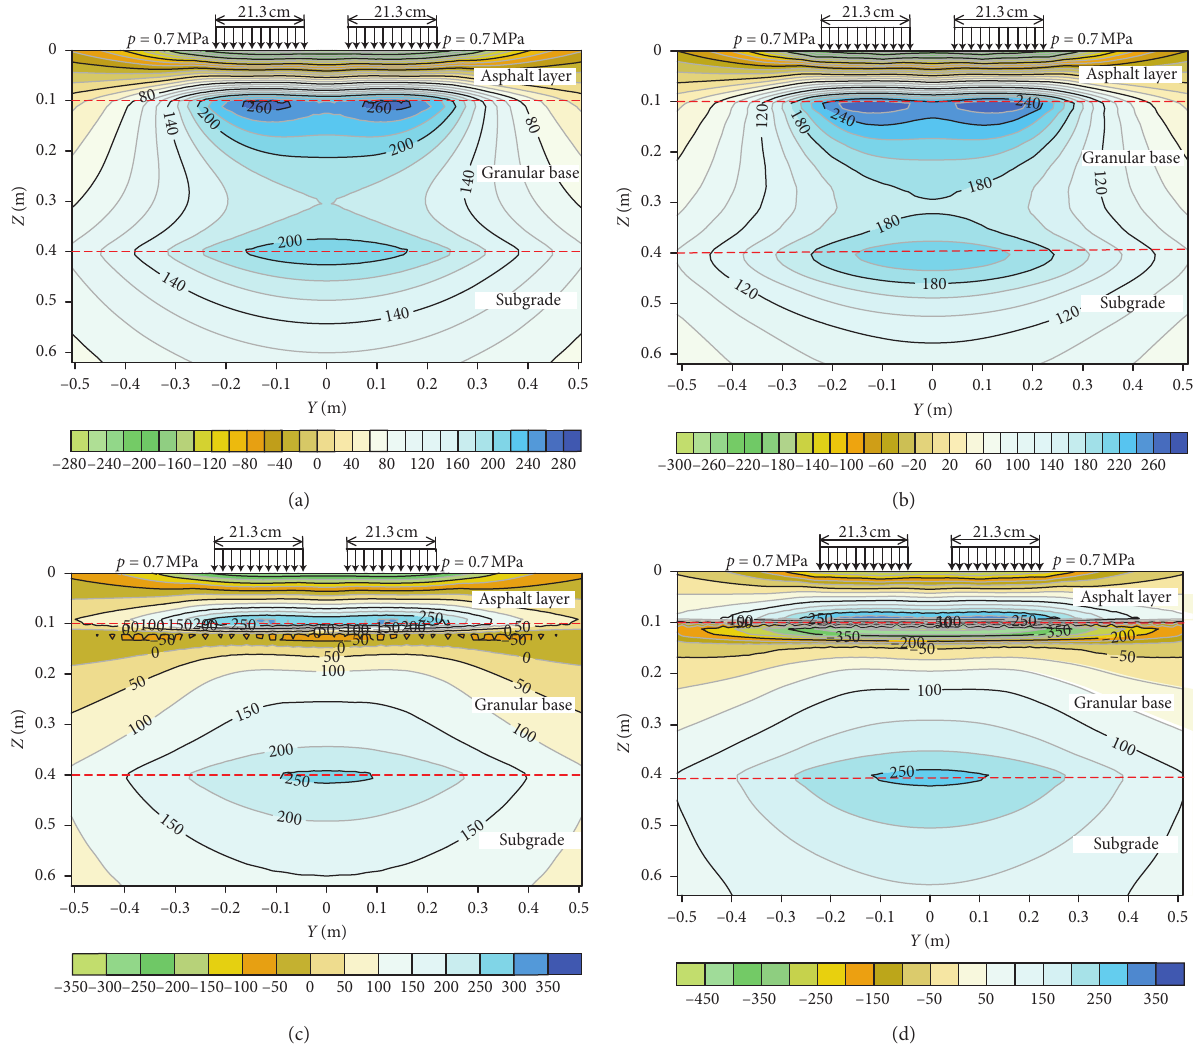
Figure 8: Contour map of cross section of flexural-tensile strain of pavement structure along driving direction ( x � 0) (unit:10 − 6 ): (a) BISAR (fully bonding of the interface between the base-surface layers); (b) EverStressFE (fully bonding of the interface between the base-surface layers); (c) BISAR (fully slipping of the interface between the base-surface layers); (d) EverStressFE (fully slipping of the interface between the base-surface